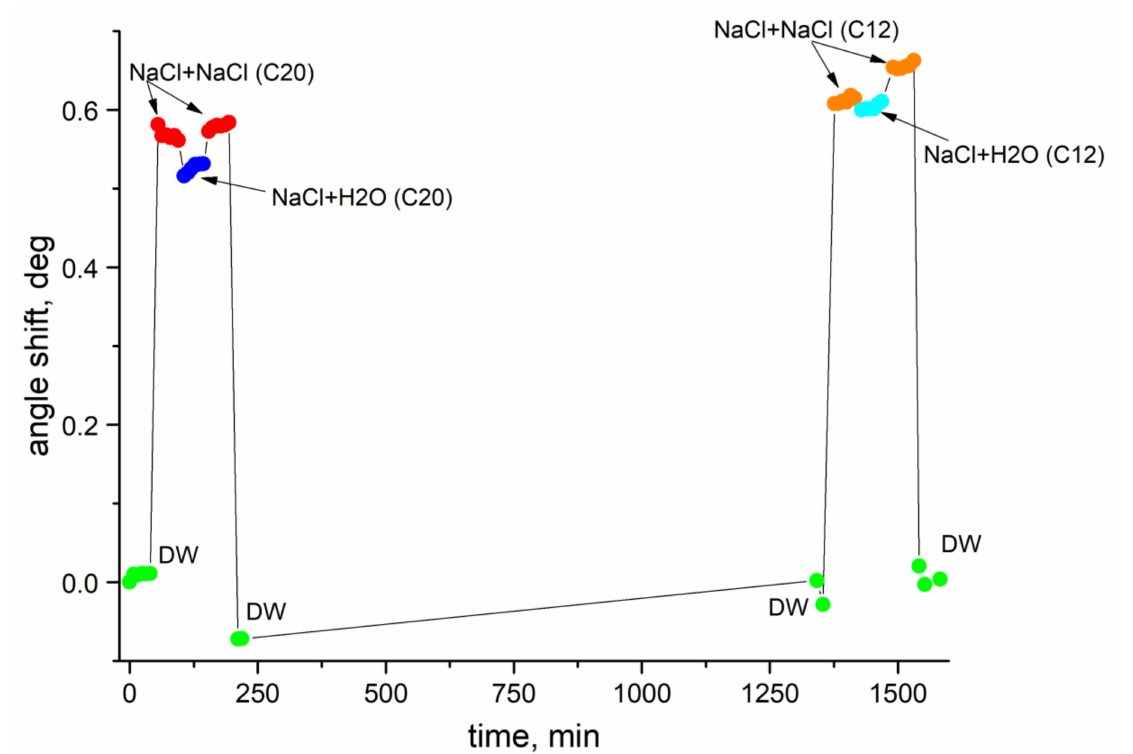
Figure 6. Comparison of the angular displacement of the minimum reflection angle of deionized water (DW) and sodium chloride solutions mixed with a NaCl dilution (C20) or a control water dilution (C20), as well as sodium chloride solutions mixed with a NaCl dilution (C12) or a control water dilution